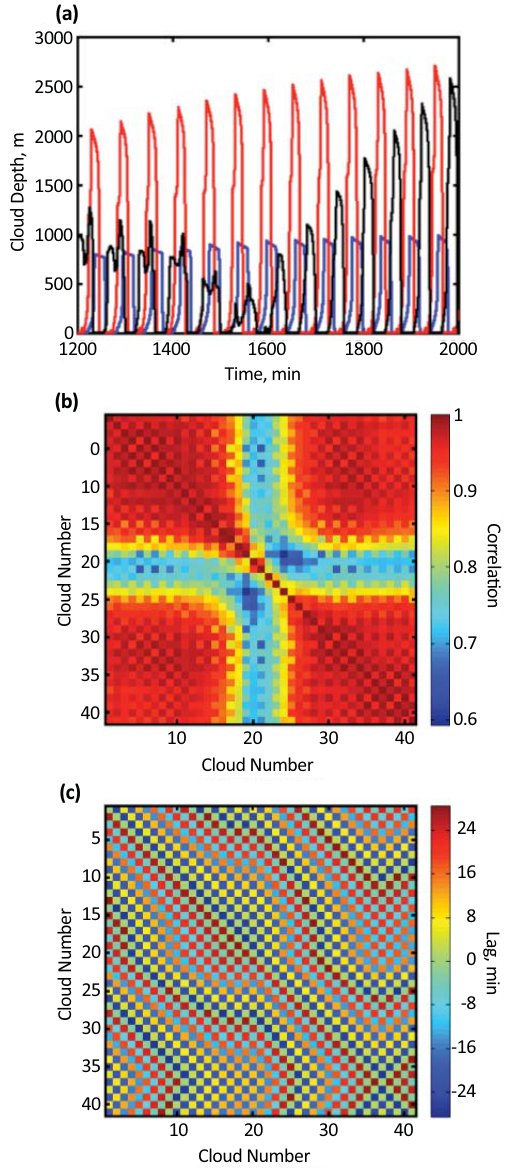
Fig. 8. Illustrative example for a one-dimensional array of 41 clouds and η = − 0 . 53: (a) time series for i = 1 (blue), 5 (red), 35 (black); (b) cross-correlation matrix where the position in the matrix indi- cates the maximum correlation r between any pair of clouds; (c) the cross-lag matrix showing the time lag at which the maximum r in (b)